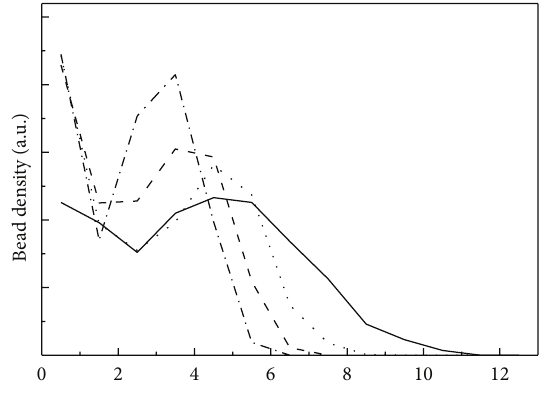
Figure 17: Temperature effect on the density profiles of end beads ( 𝜀 𝑝 𝑤 = 2𝜀 𝑝 𝑏 = 2𝜀 ) as a function of the distance from the wall ( 𝑧[𝜎] ). 𝑇 = 0.5𝜀/𝑘 𝐵 (dot-dashed line), 𝑇 = 0.8𝜀/𝑘 𝐵 (dashed line), 𝑇 = 1.5𝜀/𝑘 𝑇 = 1.0𝜀/𝑘 𝐵 (dotted line), and 𝐵 (solid